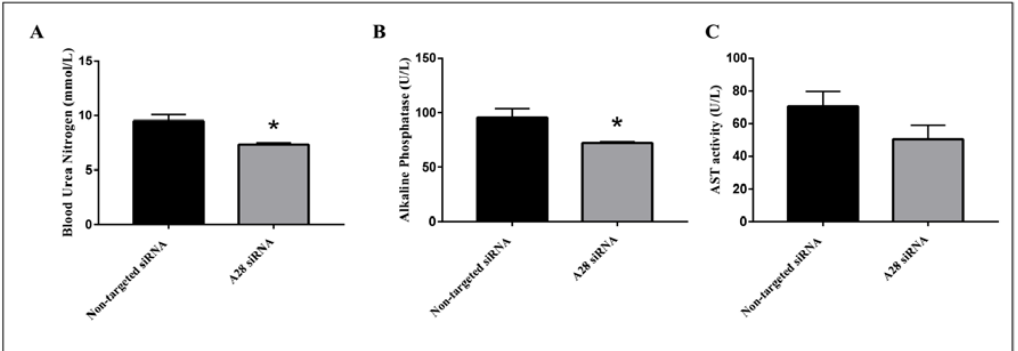
Figure 8. Metabolic benefits in mice treated with ADAM28 siRNA. Blood urea nitrogen ( A ); Alkaline Phosphatase ( B ); and aspartate aminotransferase (AST) activity ( C ). * p < 0.05; n = 3 mice/group.